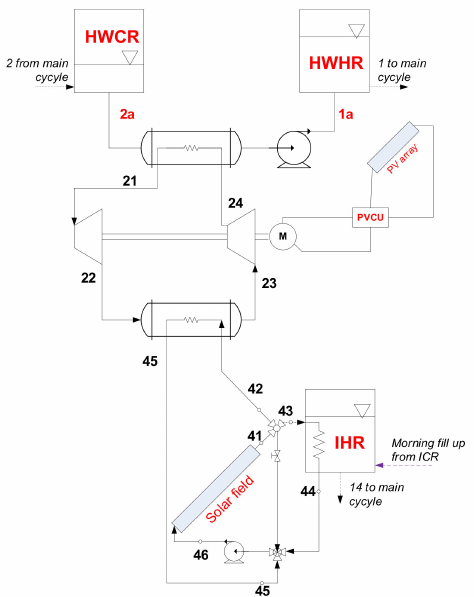
Figure 1. Scheme of the solar-assisted heat pump